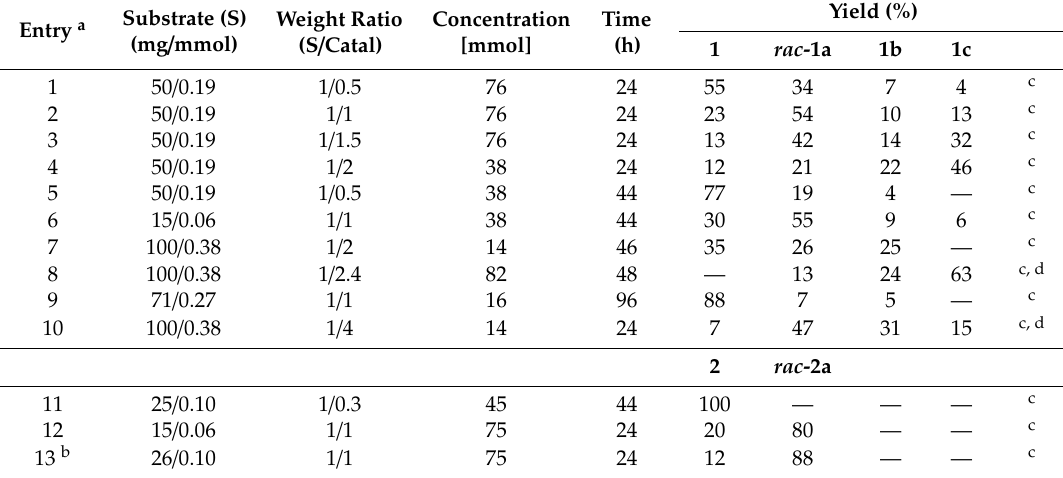
Table 2. Reaction conditions for the catalytic hydrogenation of compounds 1 and 2 with 10% Pd / C, at room temperature (rt) and 65 psi of H 2 pressure.